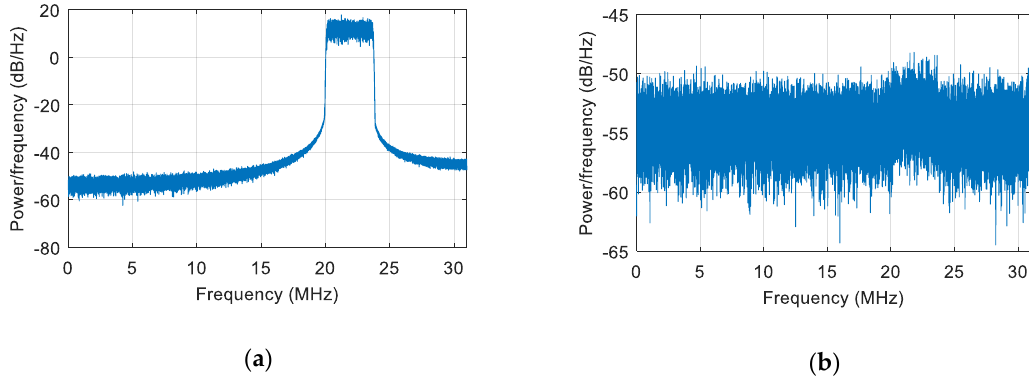
Figure 10. The power spectral density of the signal in the lower dynamic scene. ( a ) The power spectral density of the signal before interference suppression; ( b ) the power spectral density of the signal after interference suppression.